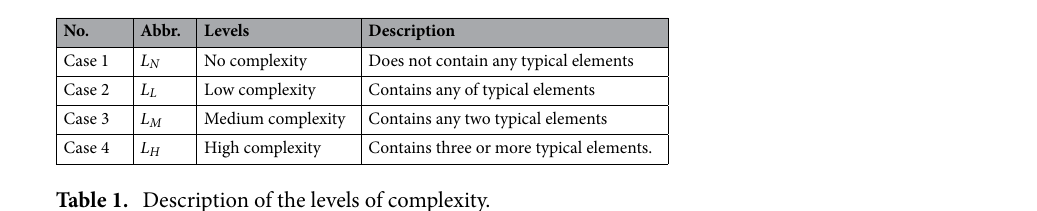
Table 1. Description of the levels of complexity.